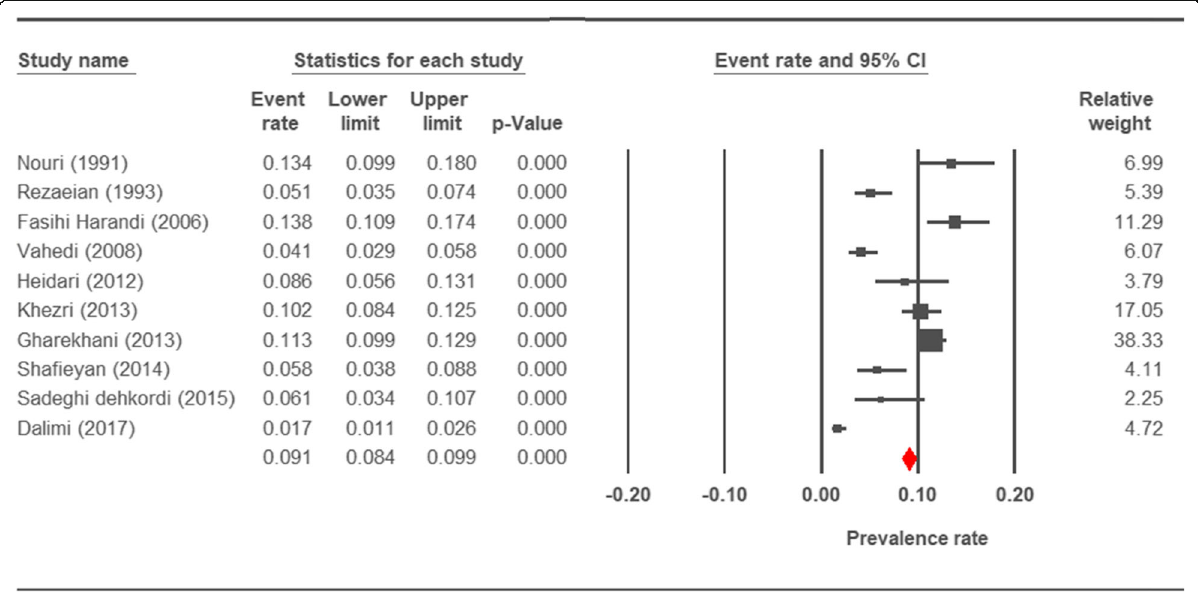
Fig. 8 Forest plot diagram showing the prevalence rate of Cryptosporidium infection in sheep of